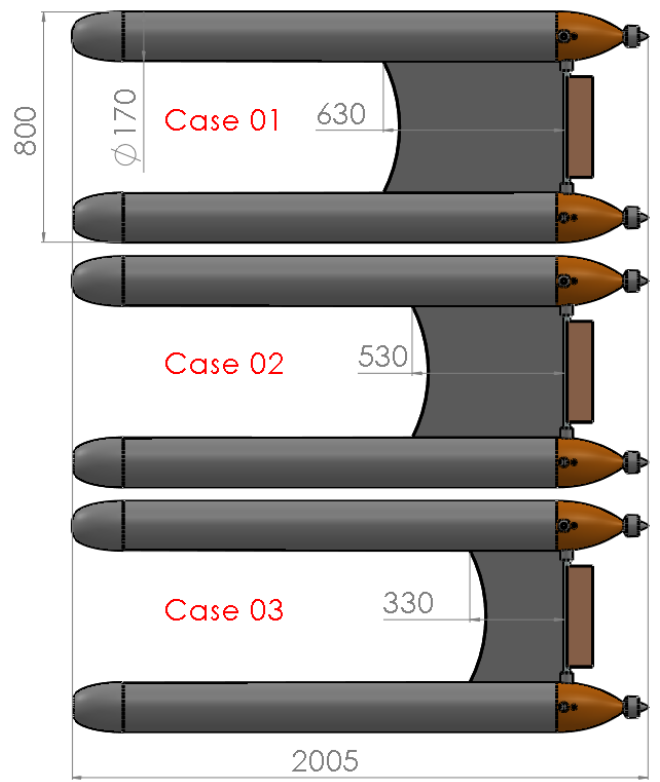
Figure 7. Three cases with different wing sizes.